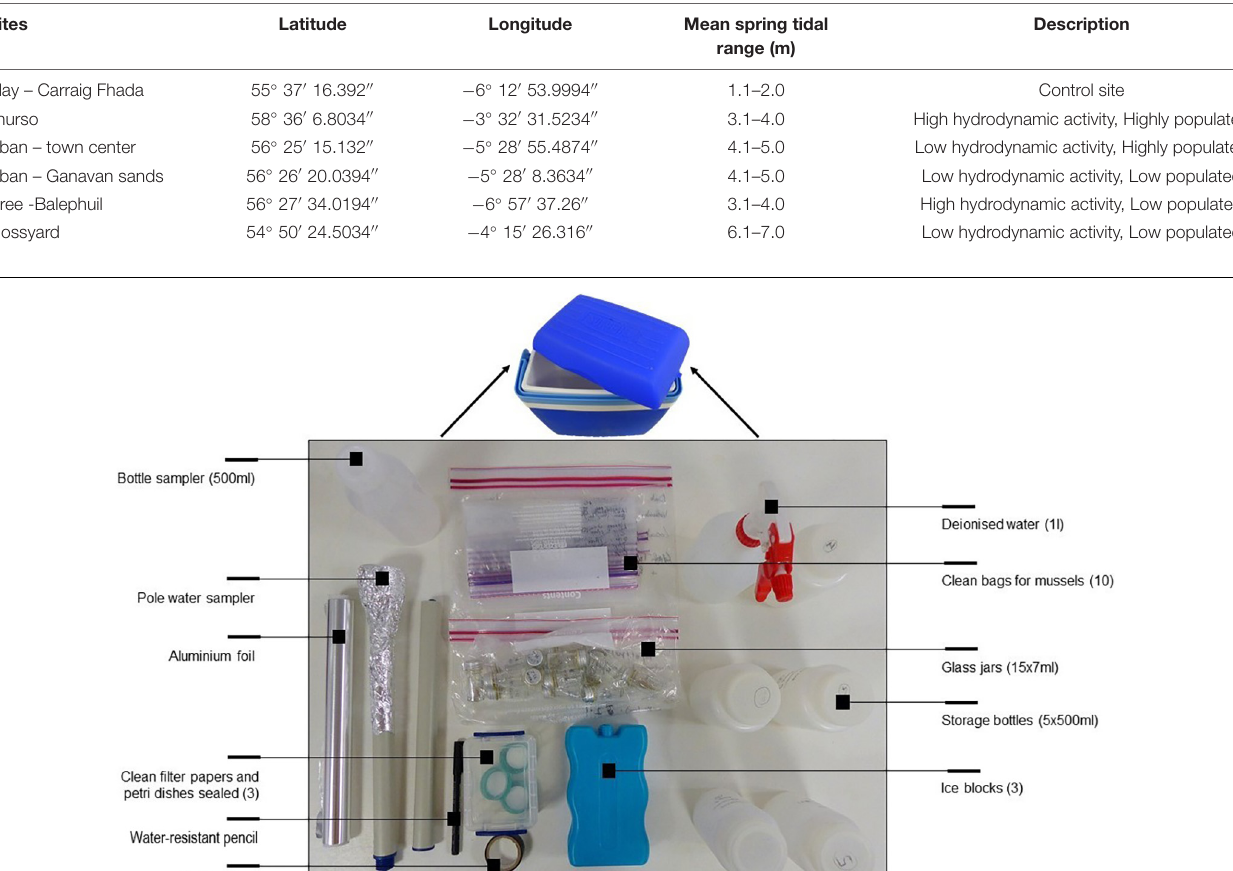
TABLE 1 | Coordinates and general description of sampling locations based on the three main parameters of interest.